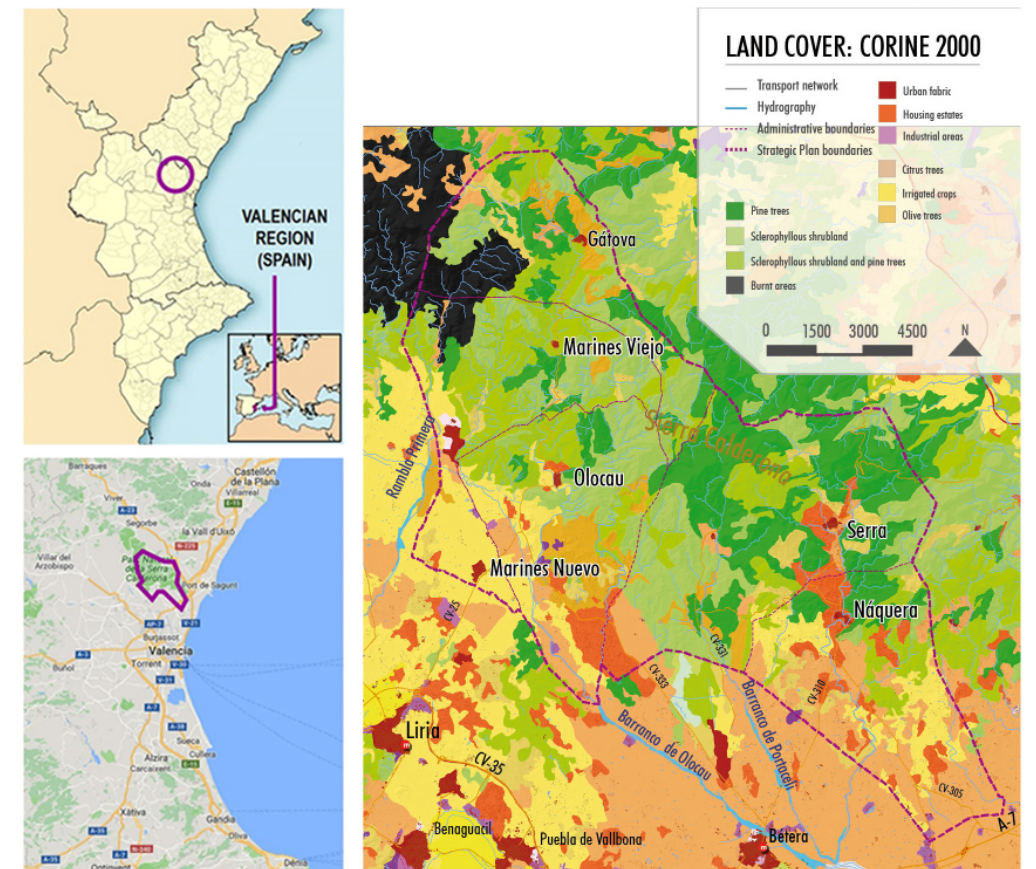
Figure 1. Location and land covers in the SCSP (municipalities of Serra, Náquera, Marines, Olocau and Gátova, SPAIN). Source: CITMA (Galan, 2014b,